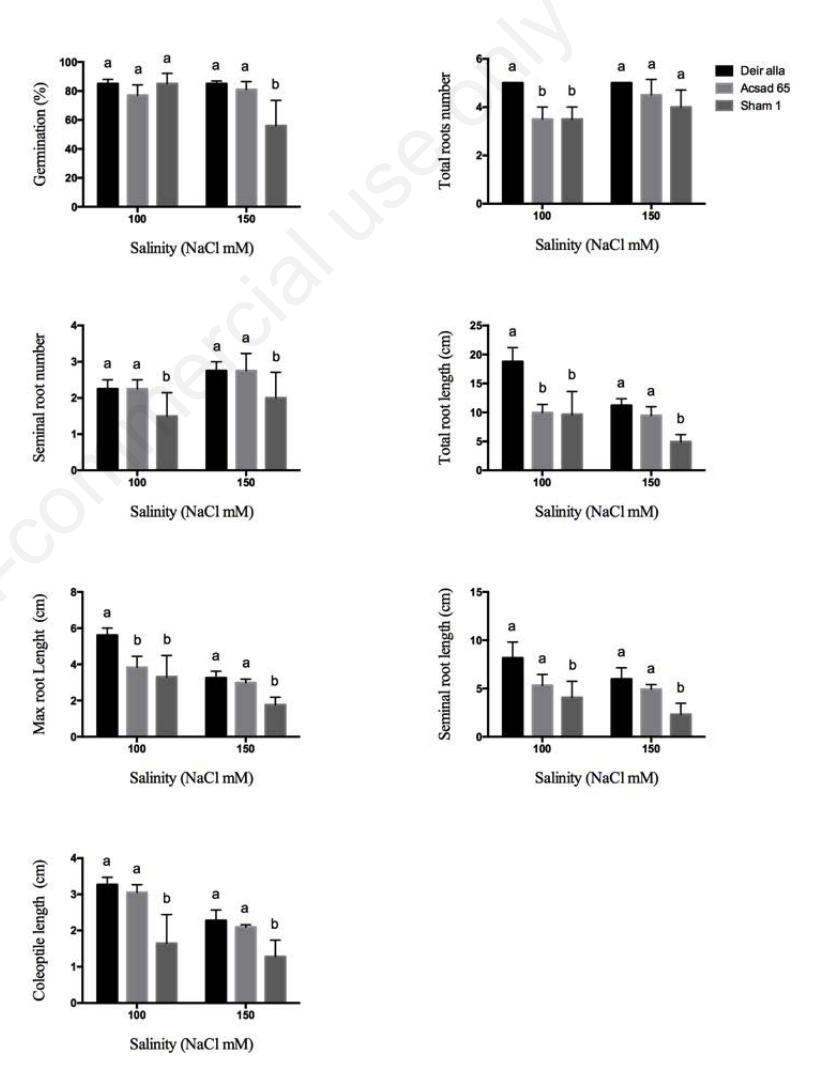
Figure 1. Genotypic variation in germination percentage and root architectural traits in three cultivars of durum wheat at salinities of 100 and 150 mM NaCl. Bars represent the means ± standard error of four individuals per genotype. Different letters indicate signif- icant differences between genotypes at P ≤ 0.05.